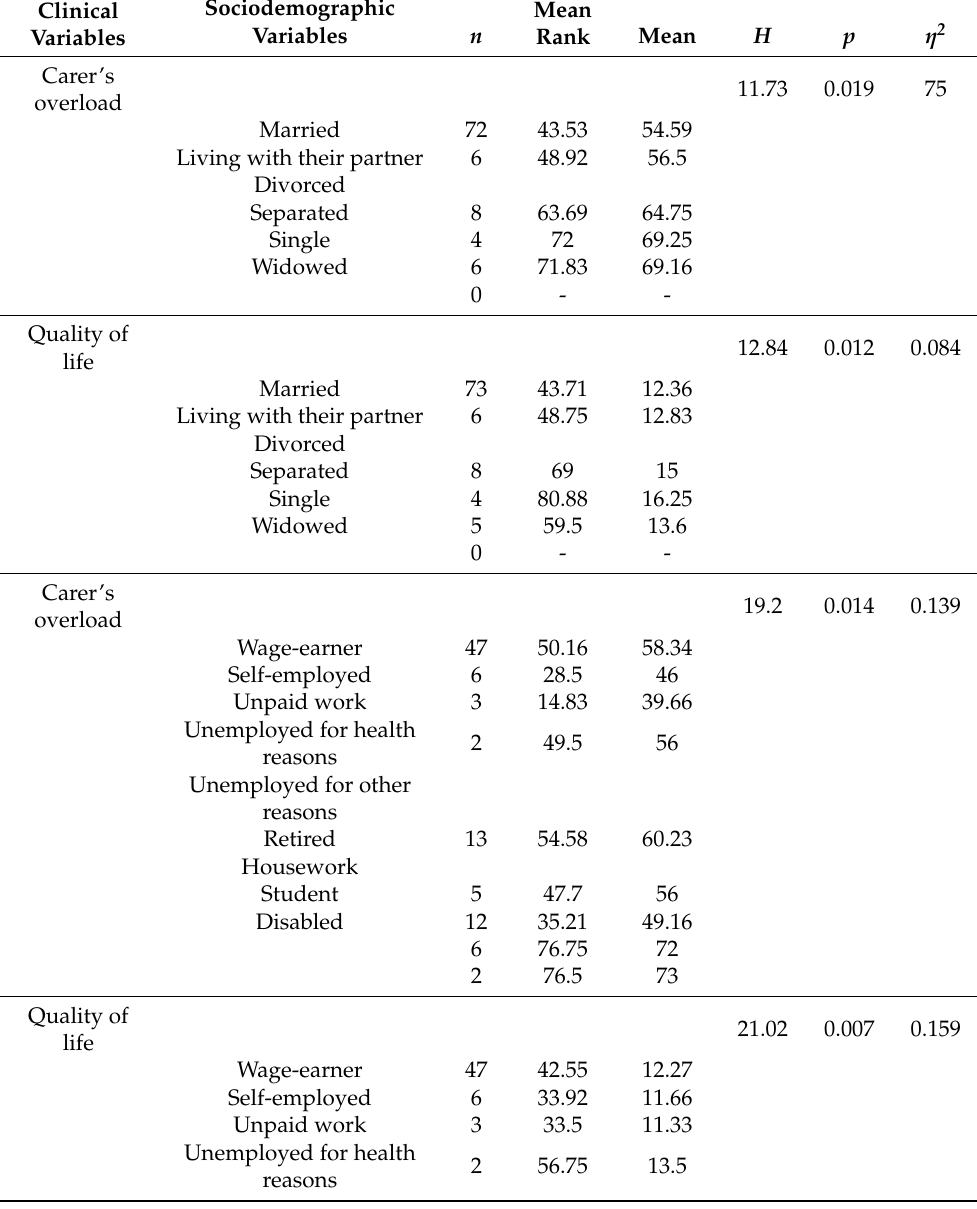
Table 5. Kruskal–Wallis test analysis of sociodemographic and clinical variables. ( n =